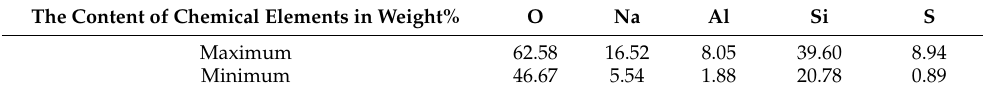
Table 3. The content of chemical elements in the additive based on synthetic aluminosilicates,